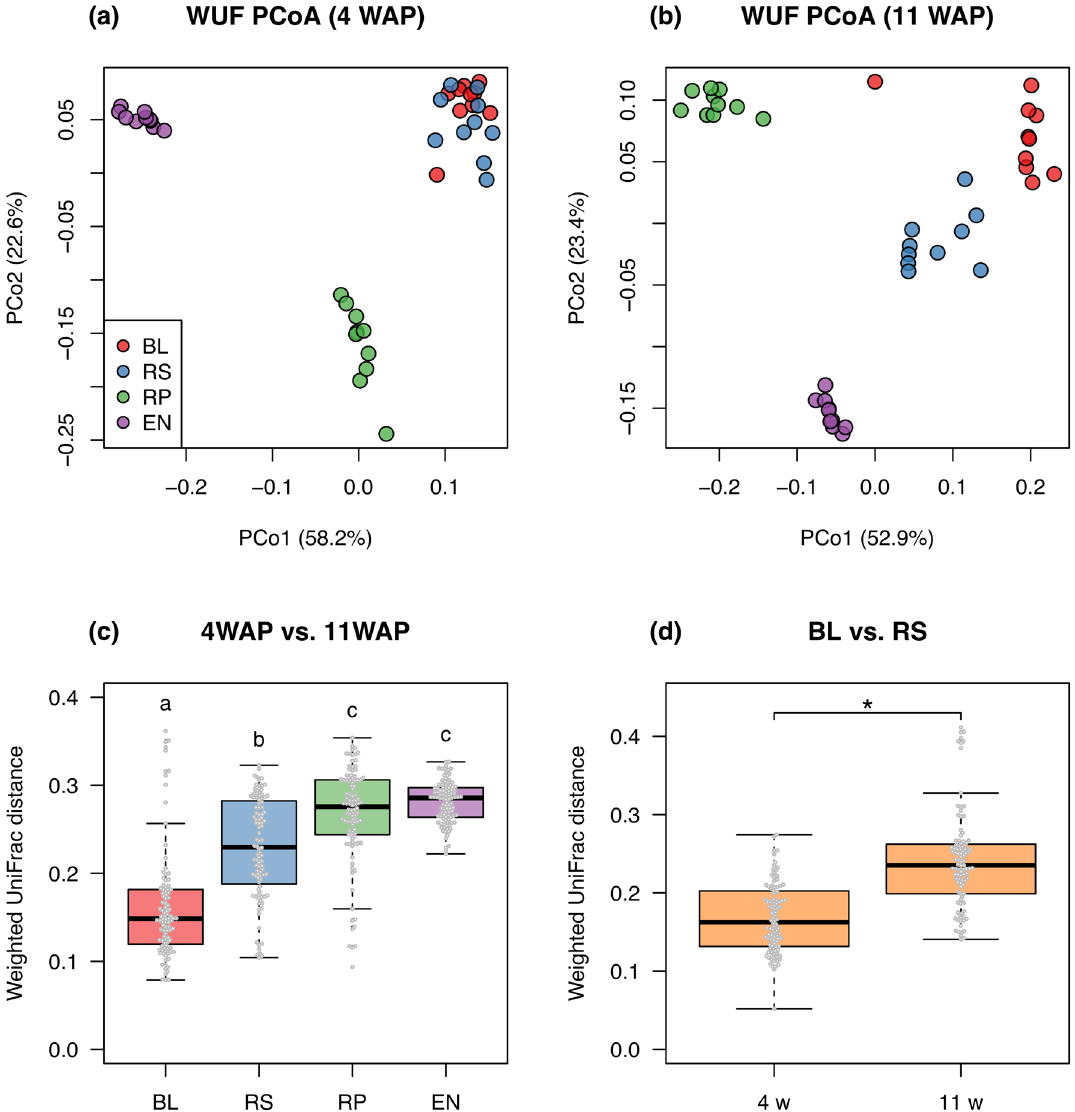
Figure 6. Dissimilarity of bacterial communities between the initial vegetative stage and later reproductive stage. ( a , b ) PCoA plots of WUF distance matrices at 4 and 11 WAP, respectively. ( c ) Boxplot of WUF distances between 4 and 11 WAP at each compartment. Different letters above boxes indicate significant differences among different compartments ( p < 0.05, Wilcoxon rank-sum test with the Bonferroni correction). ( d ) Boxplot of WUF distances between the bulk soil and rhizosphere at 4 and 11 WAP. Asterisk (*) shows significant difference ( p < 0.05, Wilcoxon rank-sum test). PCoA, principal coordinate analysis; WAP, weeks after